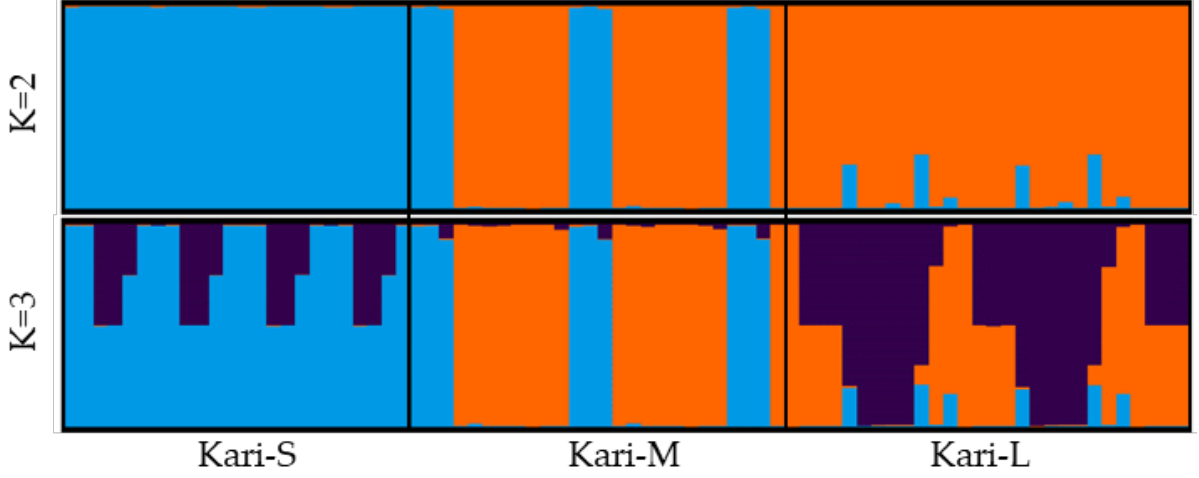
Figure 5. Summary plot showing the membership probability of individuals in the predefined subtype at different K values. Each bar represents an individual. Note that at K = 3 a cluster made by Kari-M showed a proportion of Kari-S in the ancestry; while an ancestral admixture of Kari-L was observed in the group made by Kari-S.